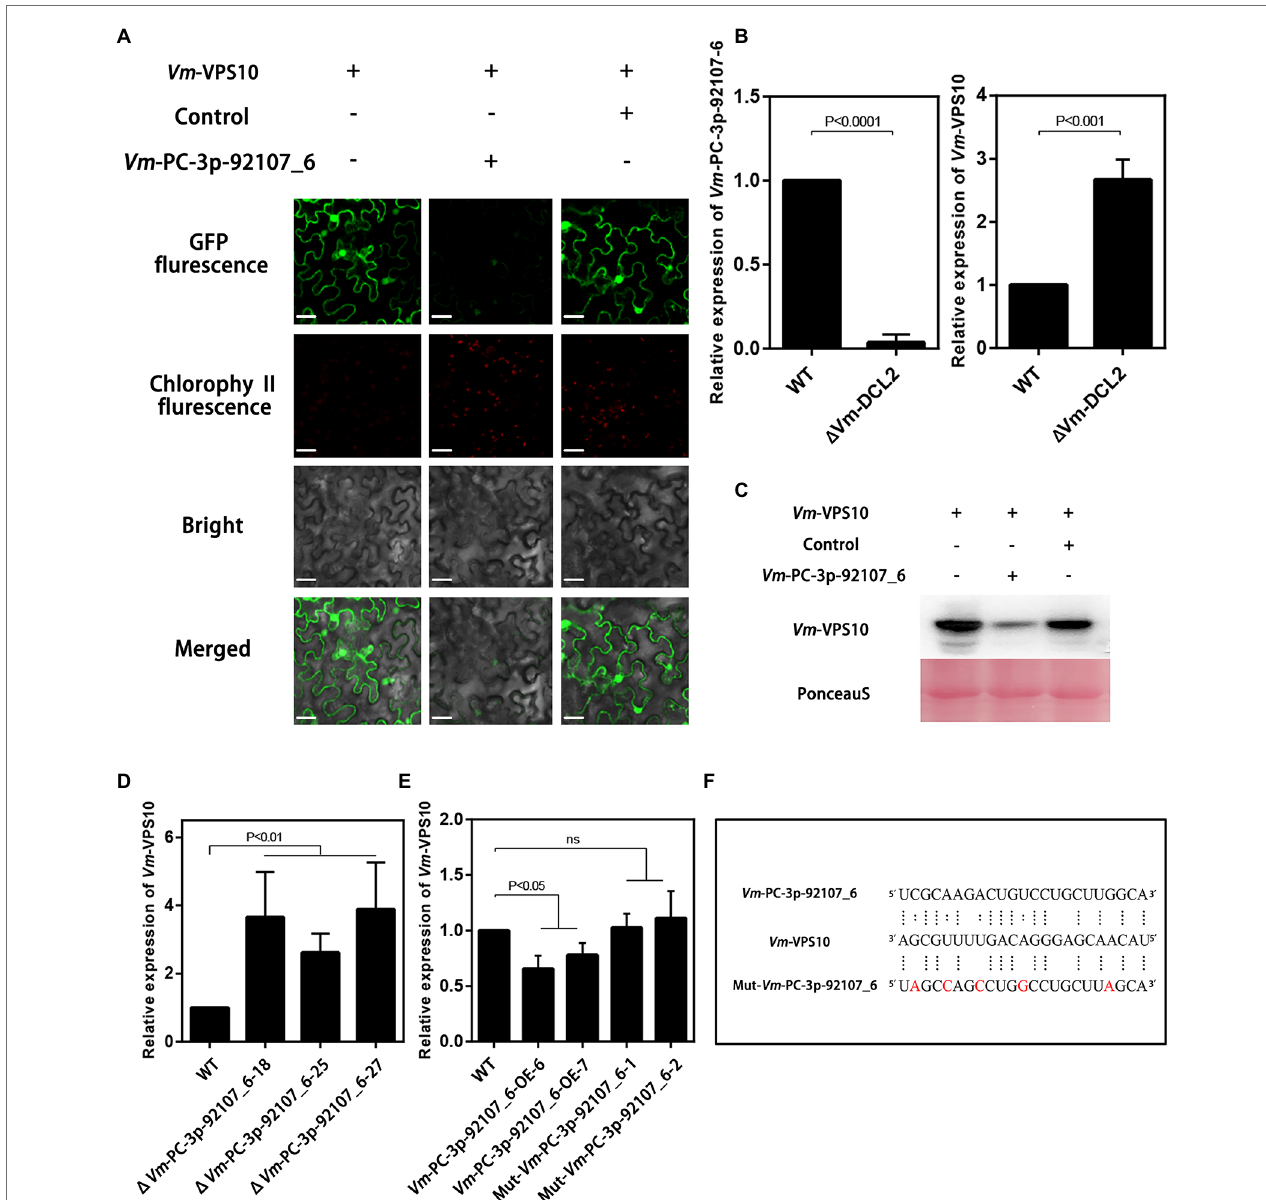
FIGURE 5 | The regulatory relationship analysis between Vm -PC-3p-92107_6 and Vm - VPS10 . (A) Vm - VPS10 expression vectors and Vm -PC-3p-92107_6-OE expression vectors were constructed, respectively. Vm -milR9 with no sequence similarity was used as the control. Confocal imaging was performed 48 h after Agrobacterium infiltration. (B) The relative expression of Vm -PC-3p-92107_6 and Vm - VPS10 in WT and Vm - DCL2 deleted mutants ( Δ Vm - DCL2 ). Vm -U6 and Vm - G6PDH were selected to reference gene using 2 - ΔΔ Ct method. And the relative expressions of Vm -PC-3p-92107_6 and Vm - VPS10 in WT were set to 1 which is taken as control. (C) Western blot analysis of eGFP- Vm - VPS10 . Anti-GFP antibodies were used for analysis. The co-expression experiment was repeated twice and similar results were obtained. (D) The relative expression of Vm - VPS10 in WT and Vm -PC-3p-92107_6 deleted mutants ( Δ Vm -PC-3p-92107_6–18, Δ Vm -PC- 3p-92107_6–25, and Δ Vm -PC-3p-92107_6–27). (E) The relative expression of Vm - VPS10 in WT and over-expression transformants of Vm -PC-3p-92107_6 ( Vm - PC-3p-92107_6-OE-6 and Vm -PC-3p-92107_6-OE-7), and mutated Vm -PC-3p-92107_6 (Mut- Vm -PC-3p-92107_6-1 and Mut- Vm -PC-3p-92107_6-2). (F) Sequence alignment of Vm - VPS10 with Vm -PC-3p-92107_6 and mutated Vm -PC-3p-92107_6